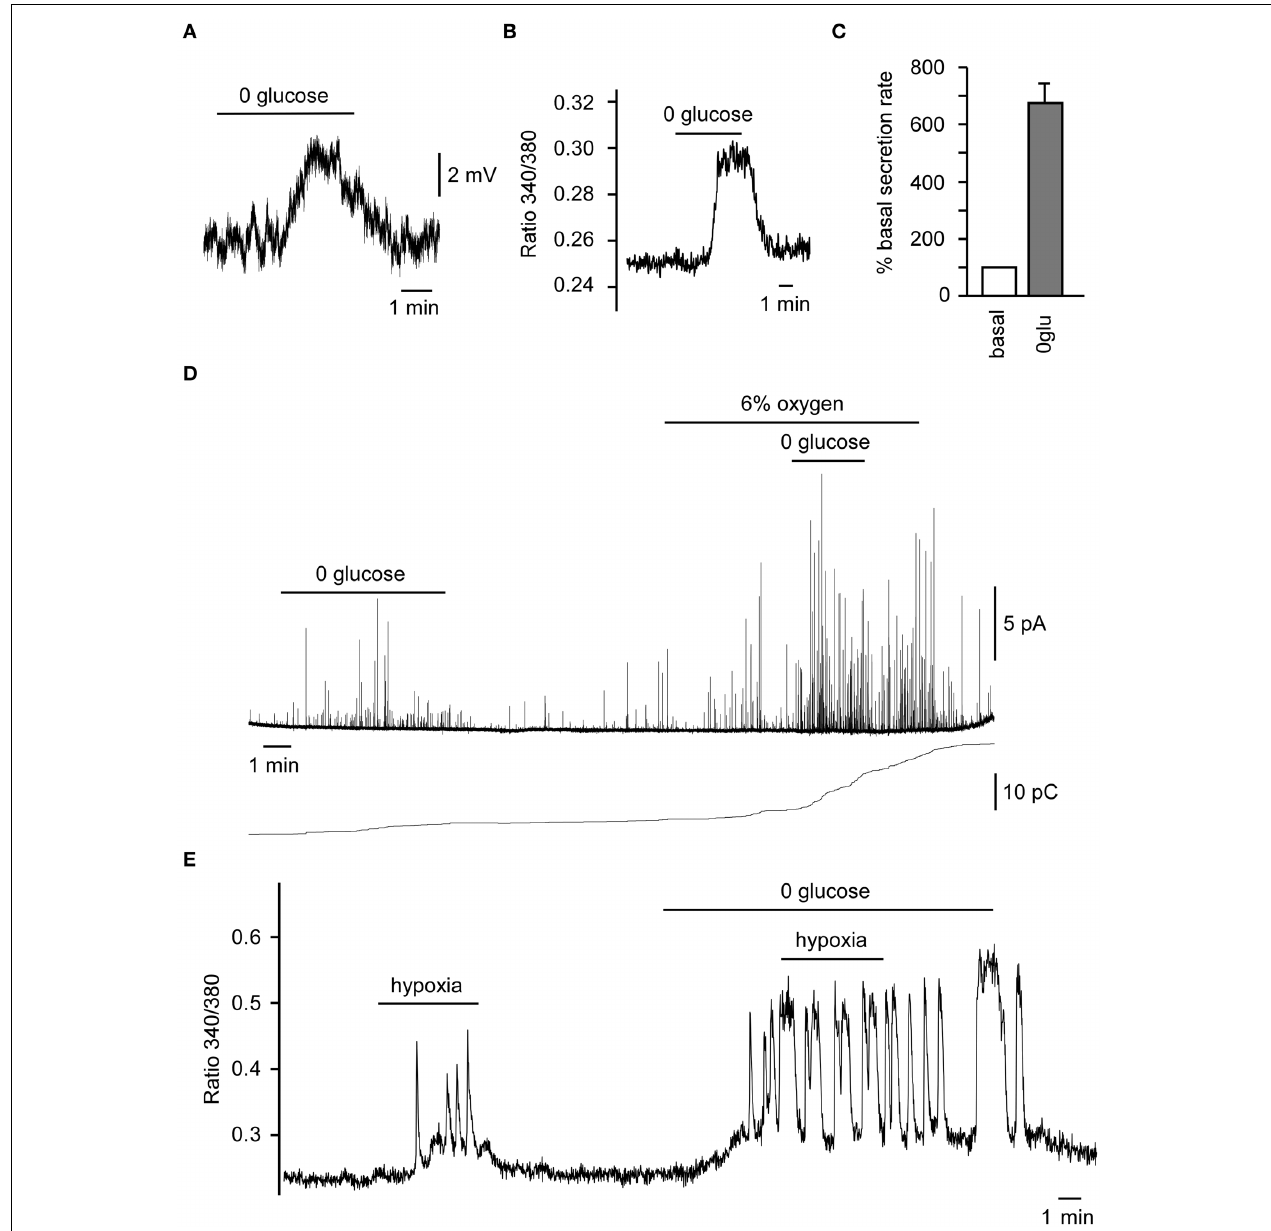
FIGURE 3 | Responses of human carotid body (CB) glomus cells to low glucose and hypoxia. ( A ) Depolarizing receptor potential recorded in a current-clamped human glomus cell in response to glucopenia. (B) Reversible increase in cytosolic Ca 2 + in a Fura-2-loaded glomus cell exposed to 0 glucose. (C) Average secretion rate induced by hypoglycemia ( n = 2). (D) Secretory response to 0 glucose of glomus cells in CB slices and